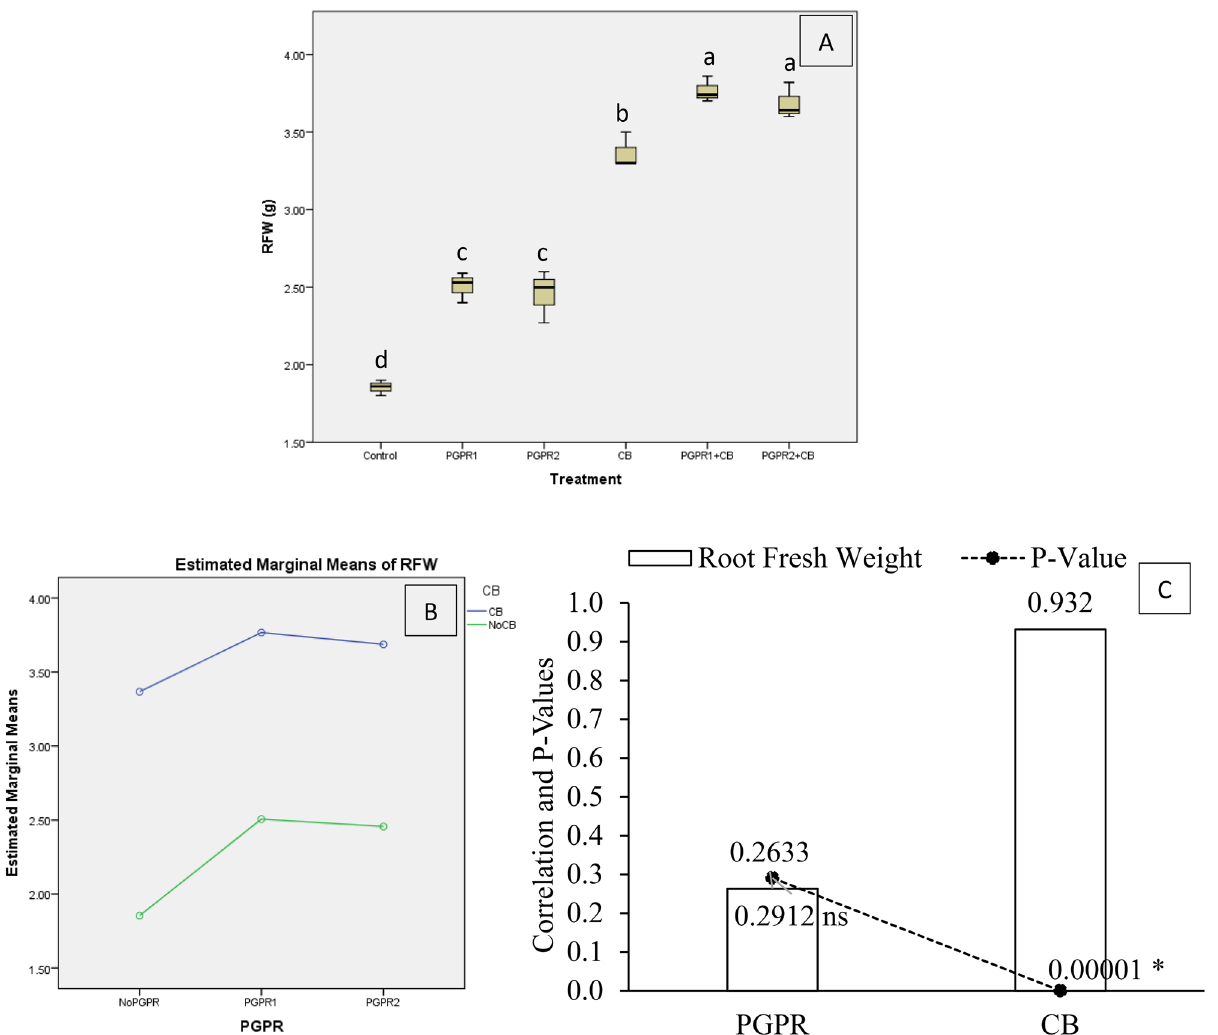
Figure 7. Effect of treatments on mint plants roots fresh weight (RFW). Values are the average of three replicates ( A ). Different letters showed significant differences (Tukey’s test; p ≤ 0.05). Interaction graph of PGPR and CB for RFW ( B ). Correlation graph of PGPR and CB for RFW ( C